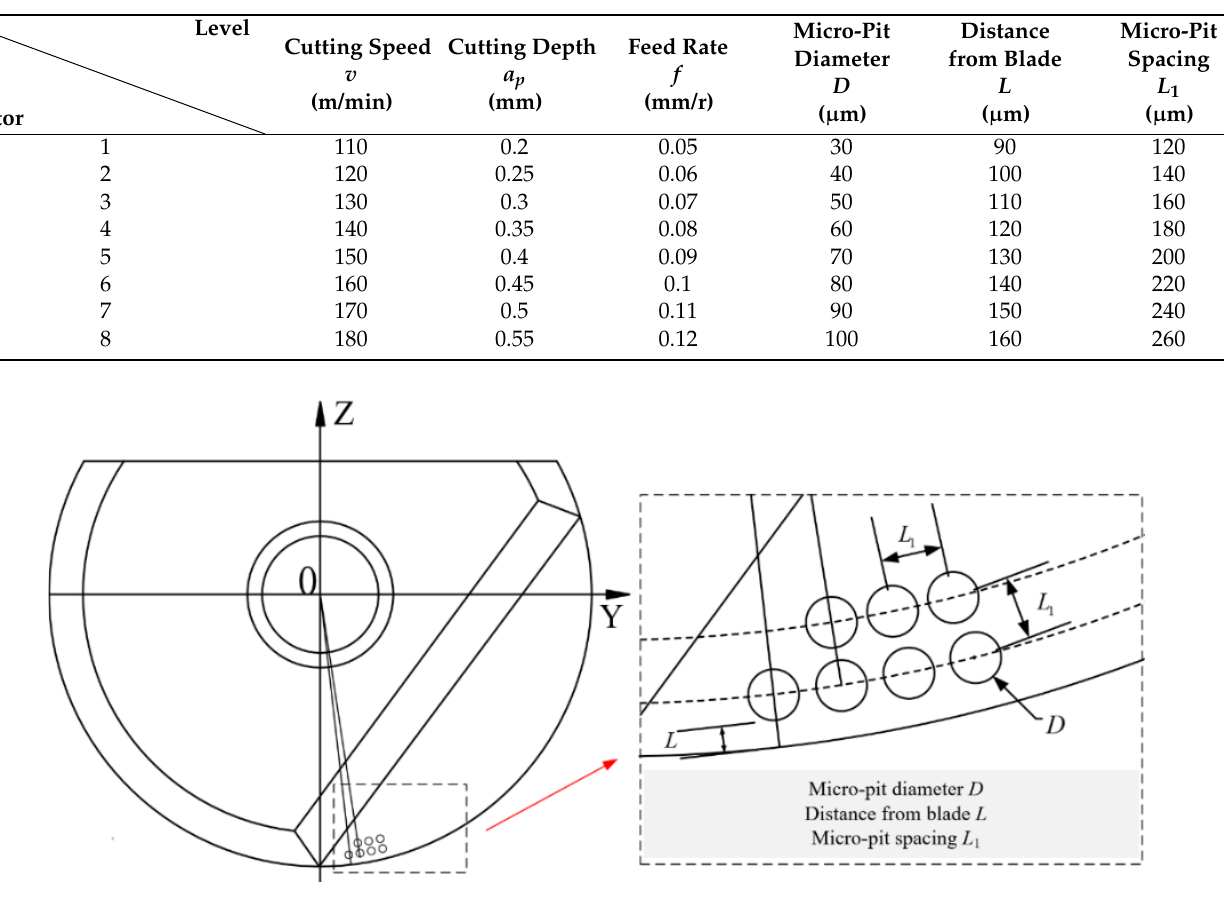
Figure 3. Parameter declaration. Table 1. Orthogonal test parameters.